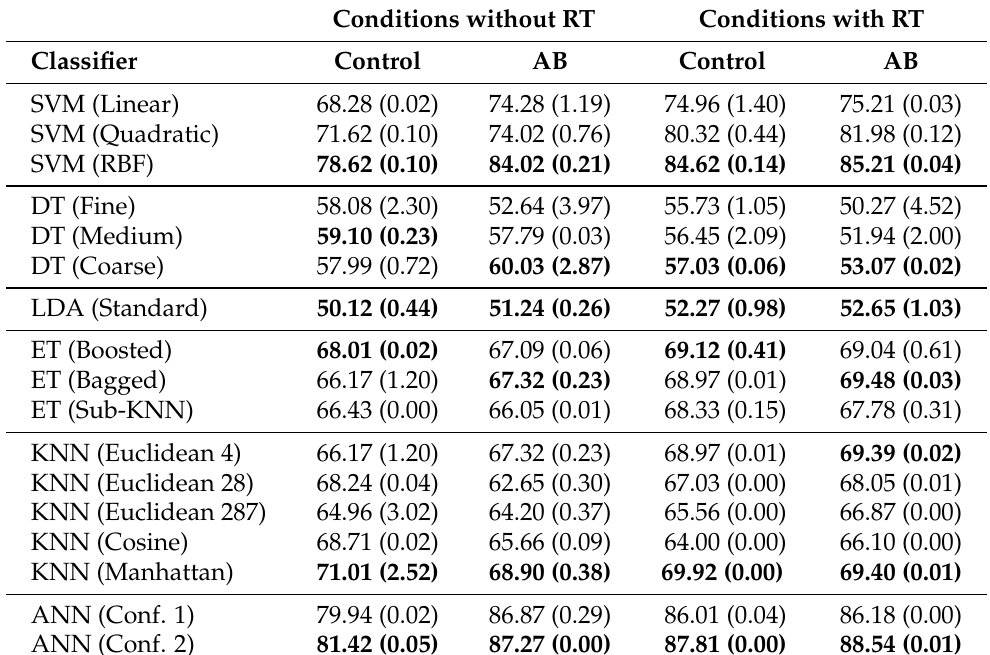
Table 6. F1-score (%) of each algorithm for each classification algorithm. Conditions without